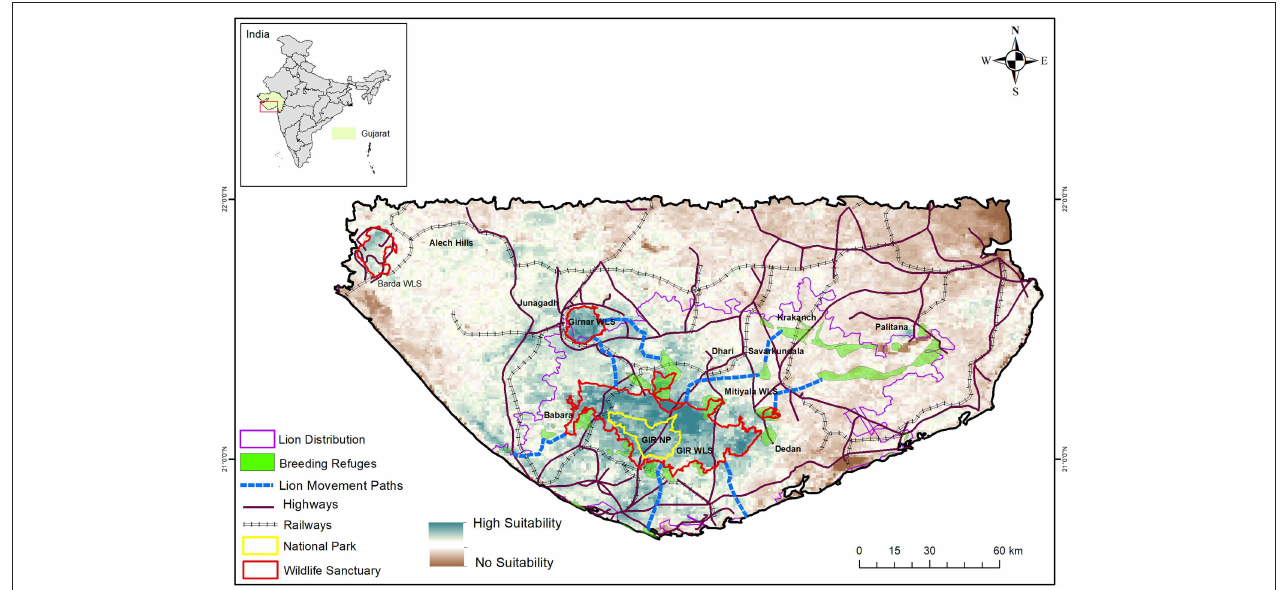
FIGURE 2 | Lion habitat suitability and current lion distribution across Saurashtra landscape overlaid with Protected Areas, breeding refuges outside the protected areas, important lion movement pathways, and linear infrastructure (major roads and railways). Note the location of Barda WLS that is being considered for lion